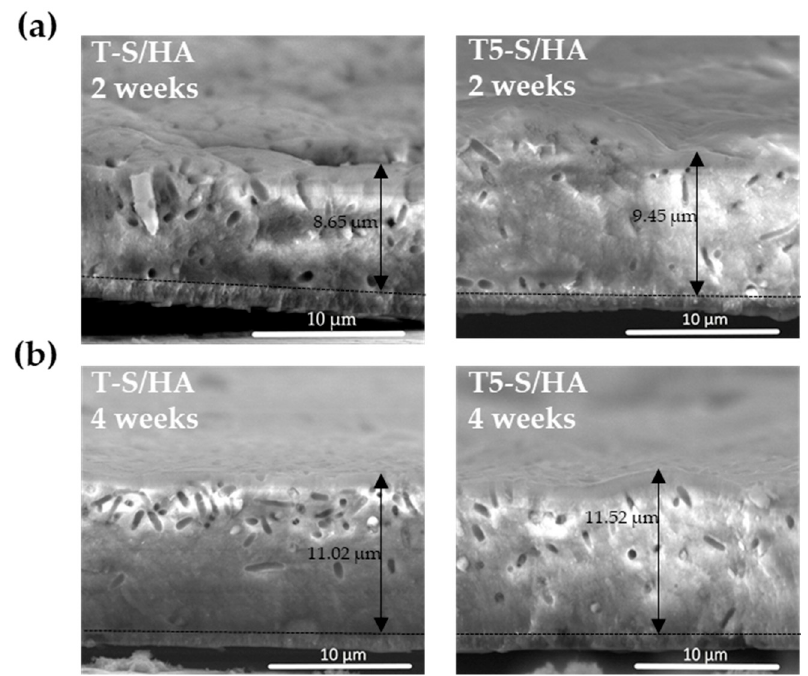
Figure 5. SEM cross-section images of T-S and T5-S with hydroxyapatite (HA) layers after immersion in SBF for 2 ( a ) and 4 ( b ) weeks. A horizontal black line separates the hydroxyapatite (HA) layer from T-S and T5-S coatings.